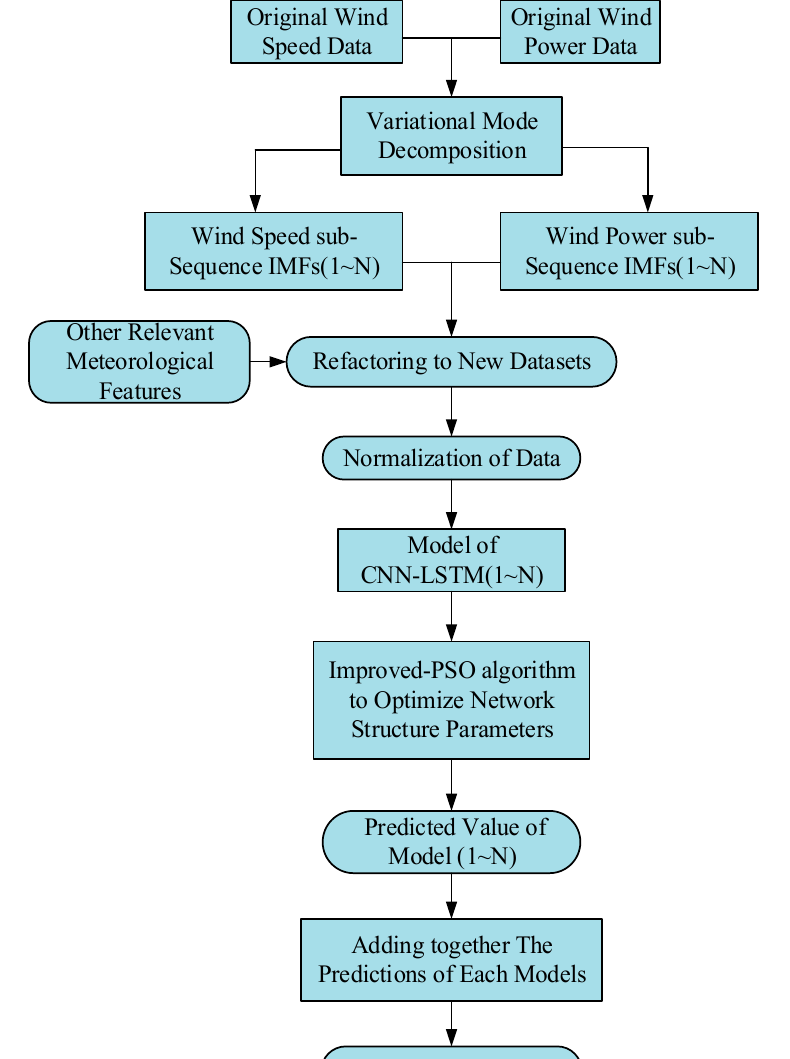
Figure 4. Flow chart of prediction model.